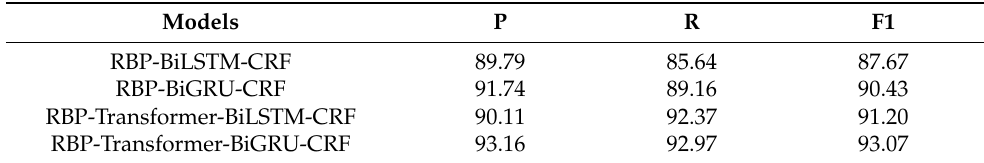
Table 6. Results of the different methods for multi-feature embedding.